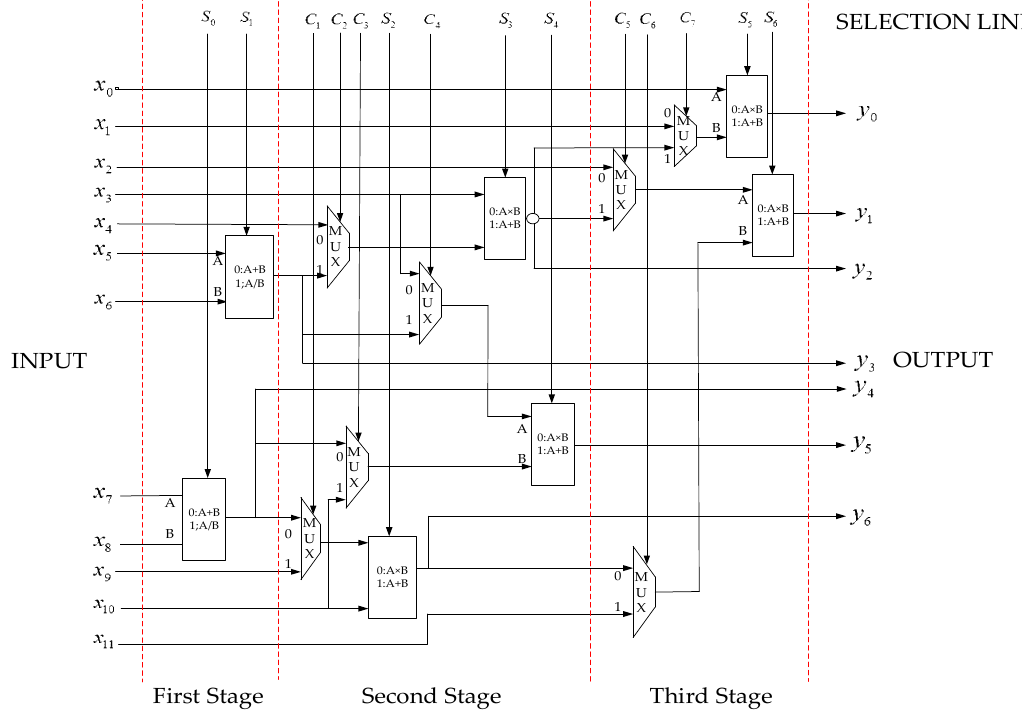
Figure 1. Arithmetic expression circuit.